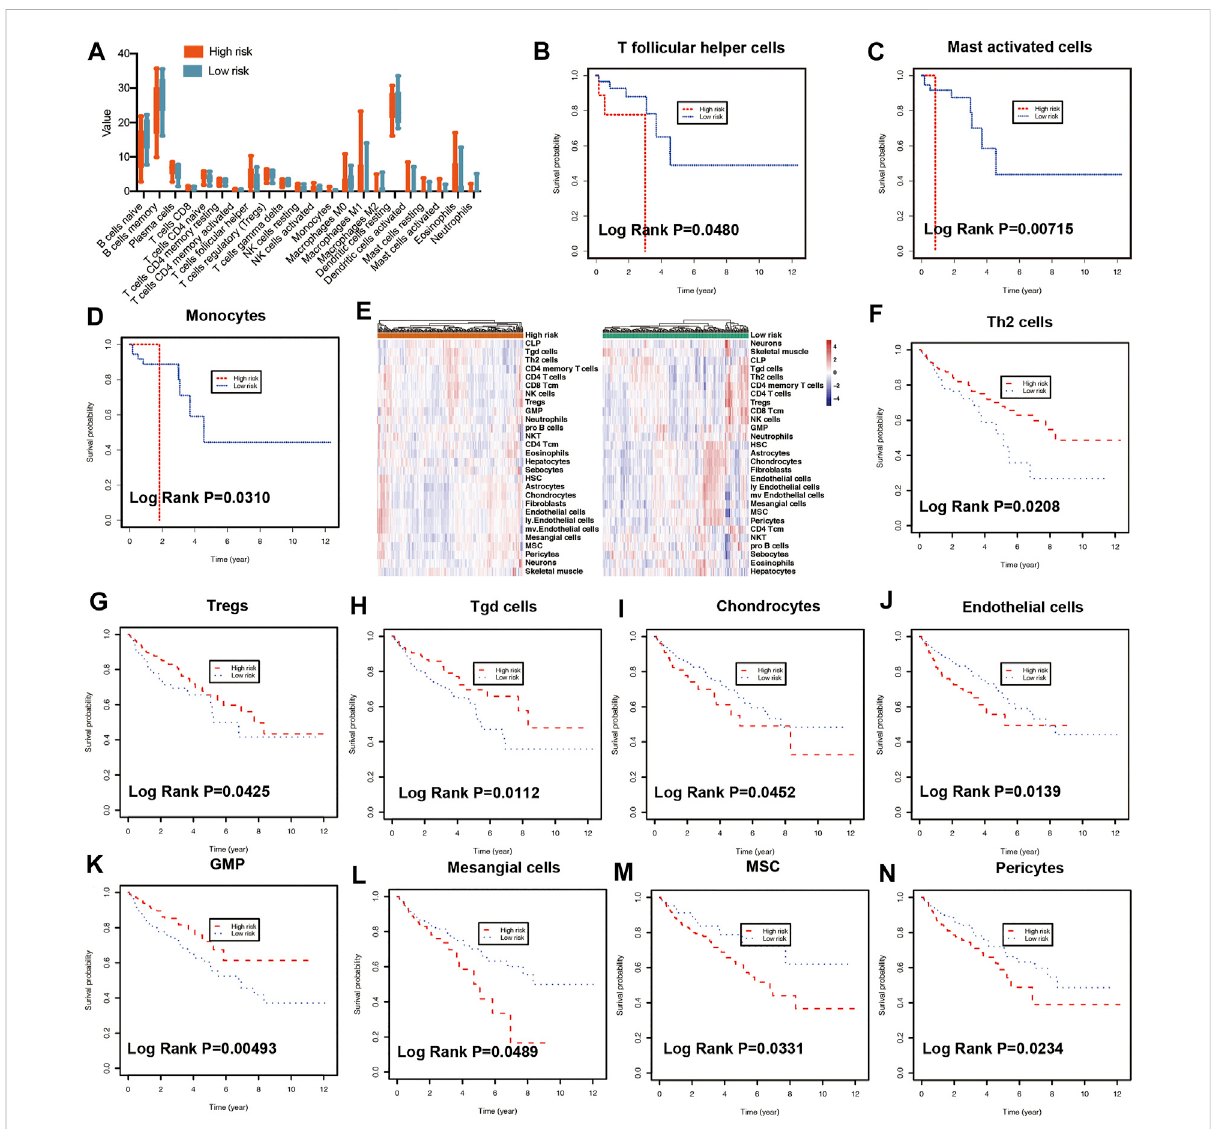
FIGURE 5 Immune characteristics of risk groups. (A) Different immune cell levels between high-risk and low-risk groups using CIBERSORT analysis. Kaplan-Meier plot showing prognostic values of the risk signature between high- and low-risk groups in multiple immune cells using CIBERSORT analysis, including T follicular helper cells (B) , mast activated cells (C) , and monocytes (D) . (E) The heatmap showing the abundance scores of immunecellsinriskgroupsusingxCellanalysis.Kaplan-Meierplotillustratingprognosticvaluesoftherisksignaturebetweenhigh-andlow-risk groups using xCell analysis in different immune cells, including Th2 cells (F) , Tregs (G) , Tgd cells (H) , Chondrocytes (I) , Endothelial cells (J) , GMP (K) , Mesangial cells (L) , MSC (M) , Pericytes (N) . Th2: T helper 2 cells, Treg: Regulatory T cells. Tgd cells: gamma delta T cells. GMP: Granulocyte- macrophage progenitor, MSC: mesenchymal stem